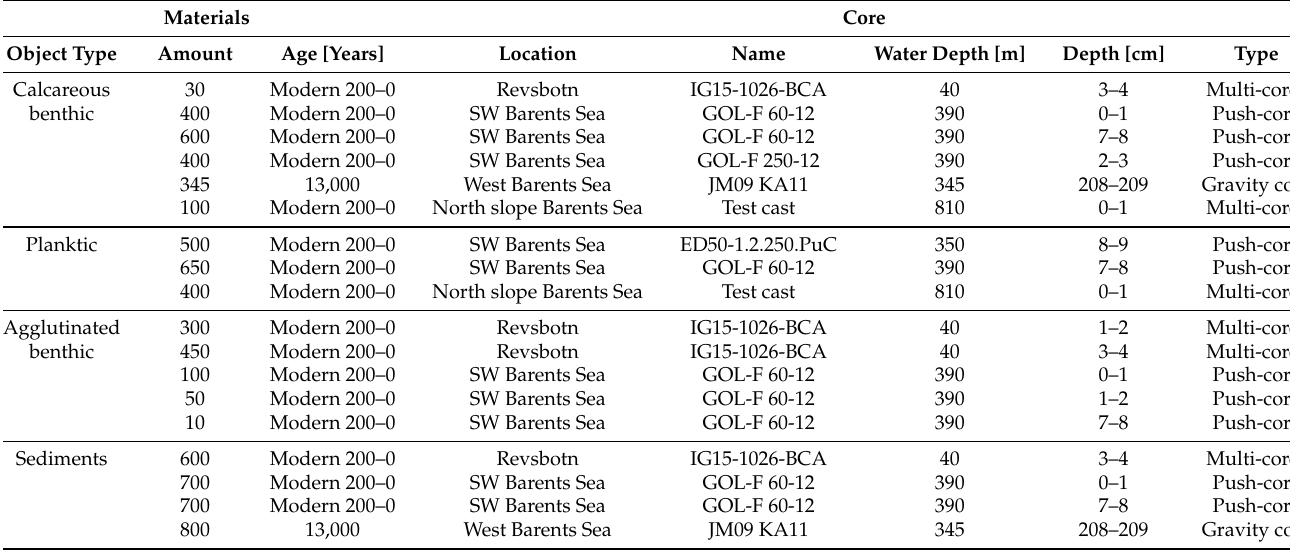
Table A1. Details about collected materials (object type, approximate amount, approximate age) and corresponding core information (location, water depth, core depth, coring method) used to create the presented